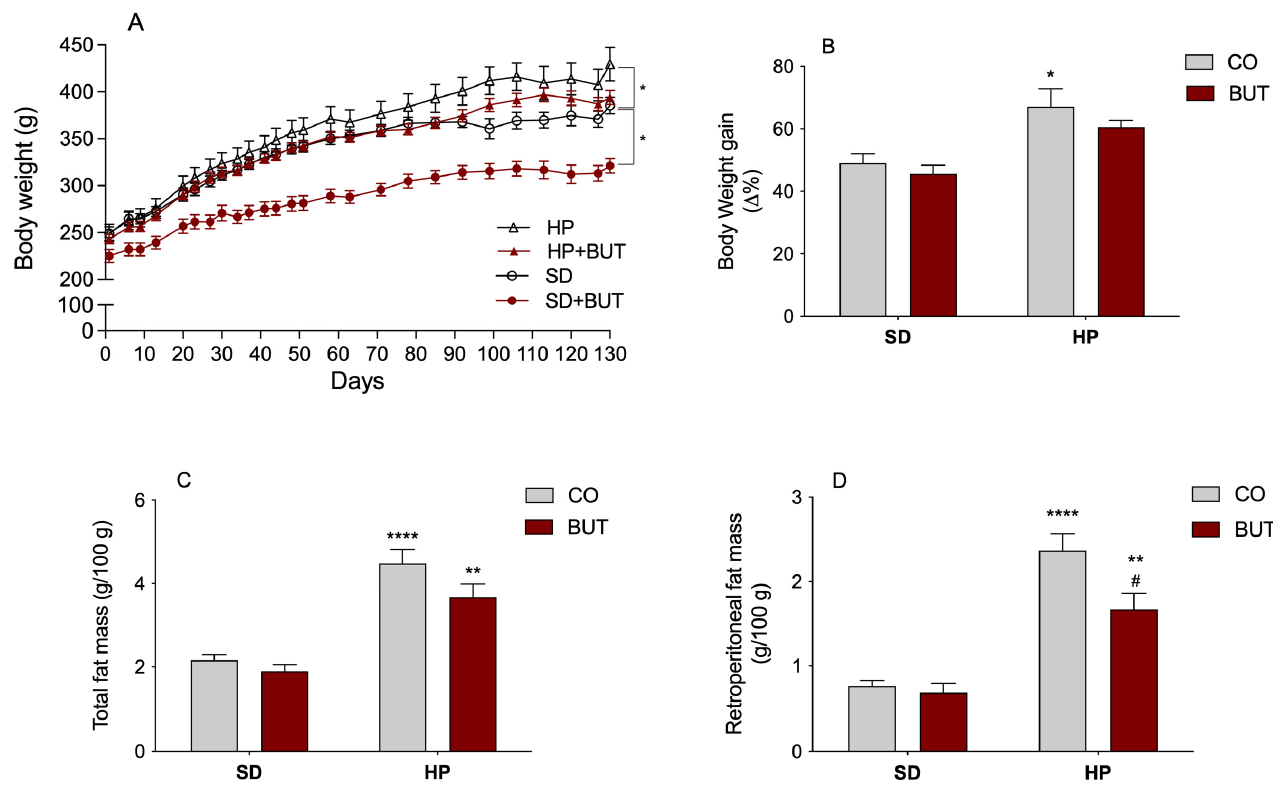
Figure 1. Effect of the C. baccatum extract (200 mg/kg, p.o.): ( A ) Growth curves of rats orally treated with C. baccatum BUT extract and different diets for 130 days; ( B ) Percentage of body weight gain in different experimental groups at the end of treatment; ( C ) Relative weight (g/100 g body weight) of the total fat mass; and ( D ) relative weight (g/100 g body weight) of the retroperitoneal fat mass after 130 days of treatment with different diets. The results are presented as the mean ± S.E.M. ( n = 10) after analysis by two-way ANOVA. * p < 0.05, ** p < 0.01, and **** p < 0.001 compared with the standard diet group (SD); # p < 0.05 compared with the ultra-processed highly palatable diet group (HP). CO: control group (saline); BUT: 200 mg/kg of C. baccatum BUT extract